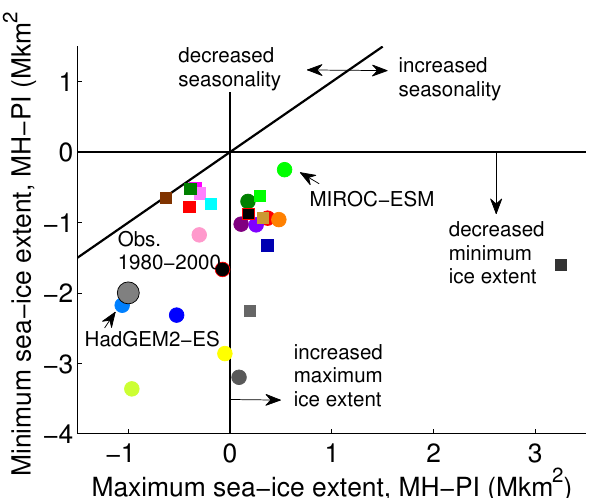
Fig. 5. Change in seasonal sea-ice extent for the PMIP2 (squares) and the PMIP3 (circles) models. The big gray circle is the difference between 1980–1989 and 2000–2009 observations. Model legends are the same as in Fig. 3. Black square and circle are the ensem- ble mean for the PMIP2 (excluding FGOALS-1.0g) and the PMIP3 models. All models have a reduced minimum sea-ice extent in mid- Holocene, the maximum sea ice extent is decreased in some models and increased in others. For most of the models, the change in sea- ice seasonality is smaller than the observed change between 1980– 1989 and